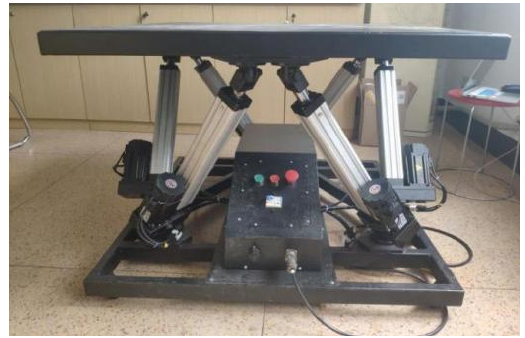
Figure 2. 6-DOF motion platform.